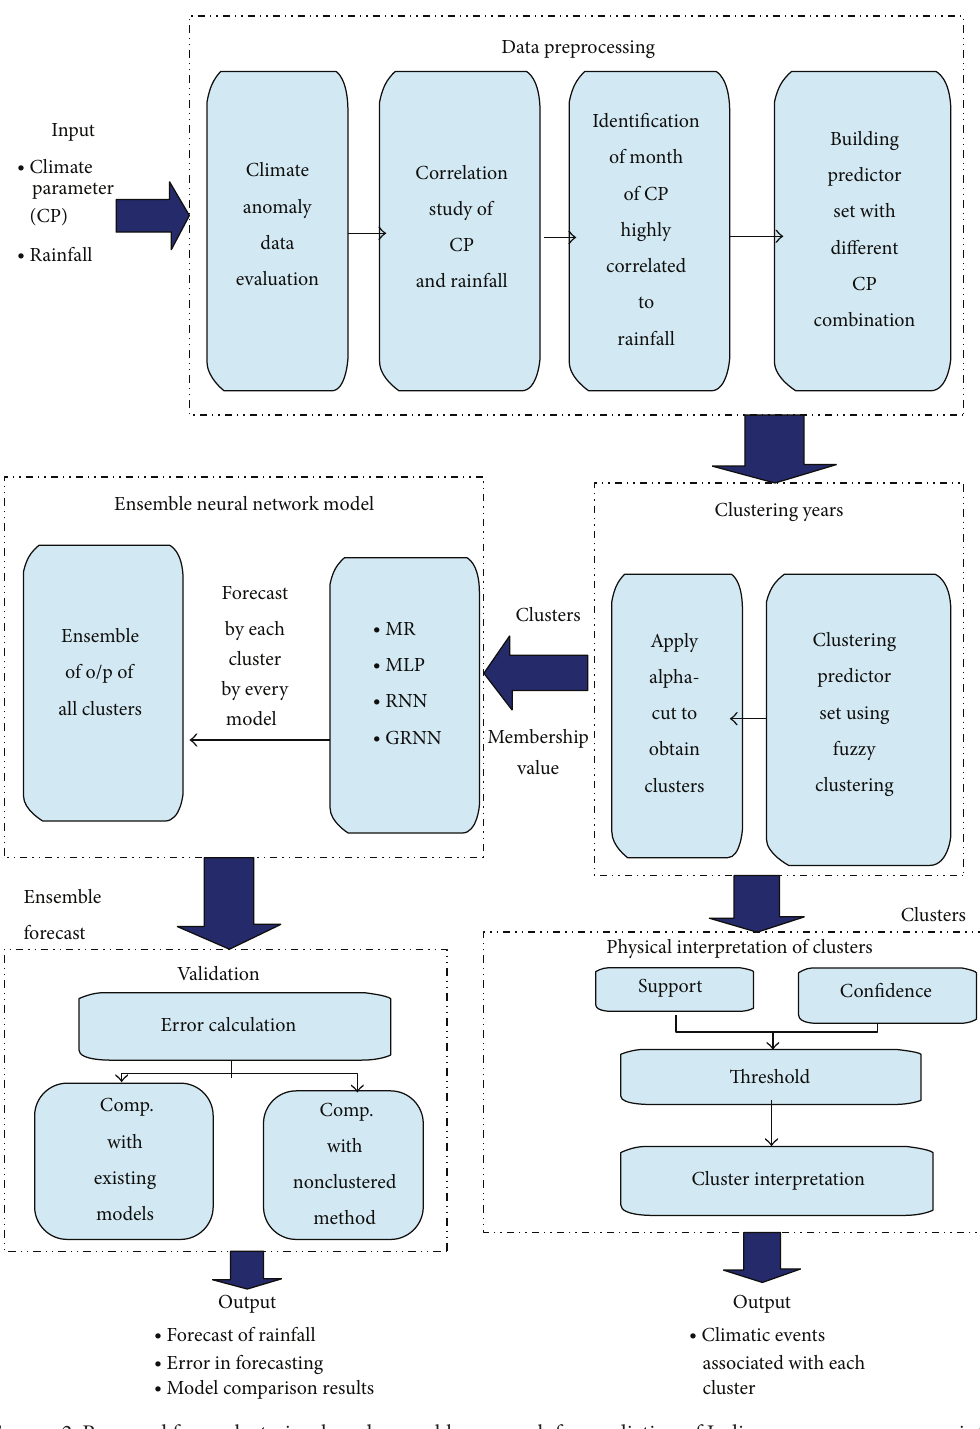
Figure 2: Proposed fuzzy clustering-based ensemble approach for prediction of Indian summer monsoon